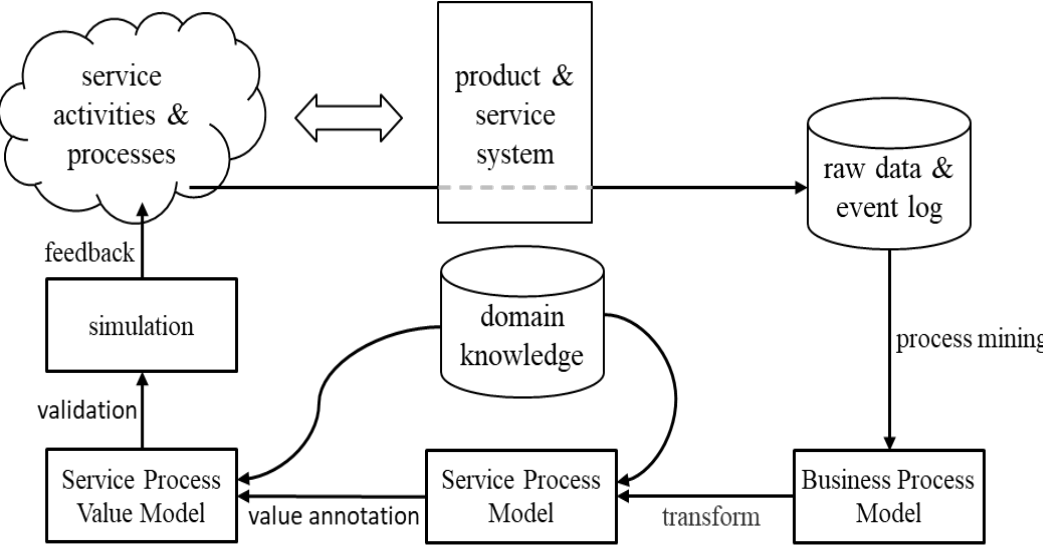
Figure 1. The general idea of the paper.